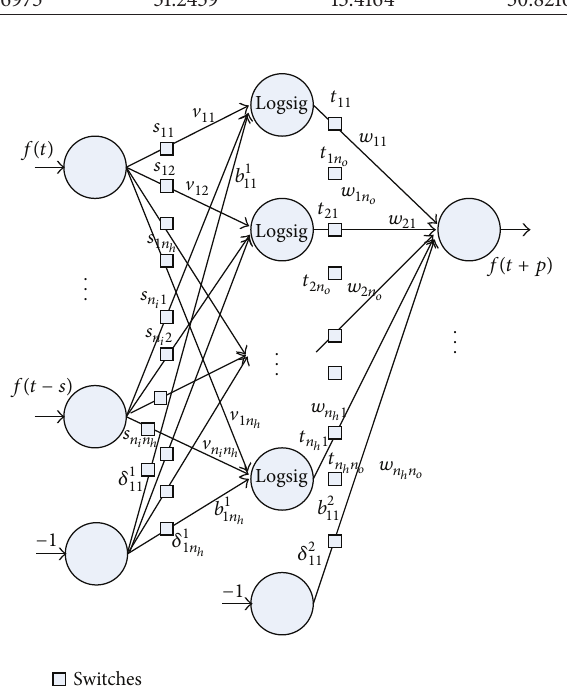
Figure 3: The structure of three-layer feedforward NN with switch-